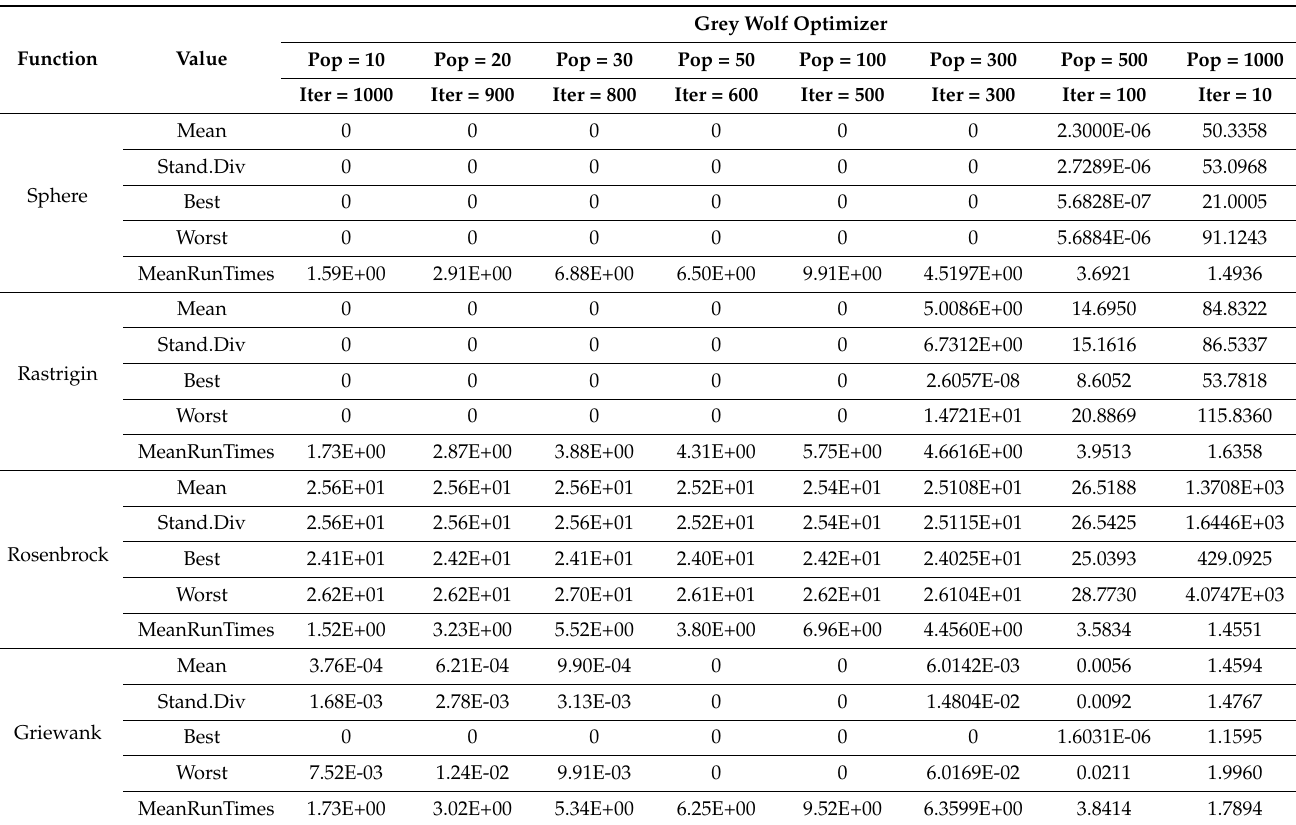
Table 14. Result for Grey Wolf